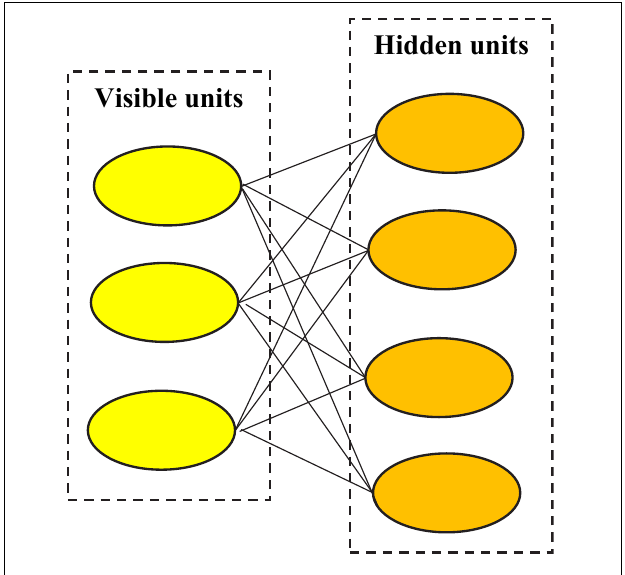
FIGURE 13 | Model structure of the restricted Boltzmann